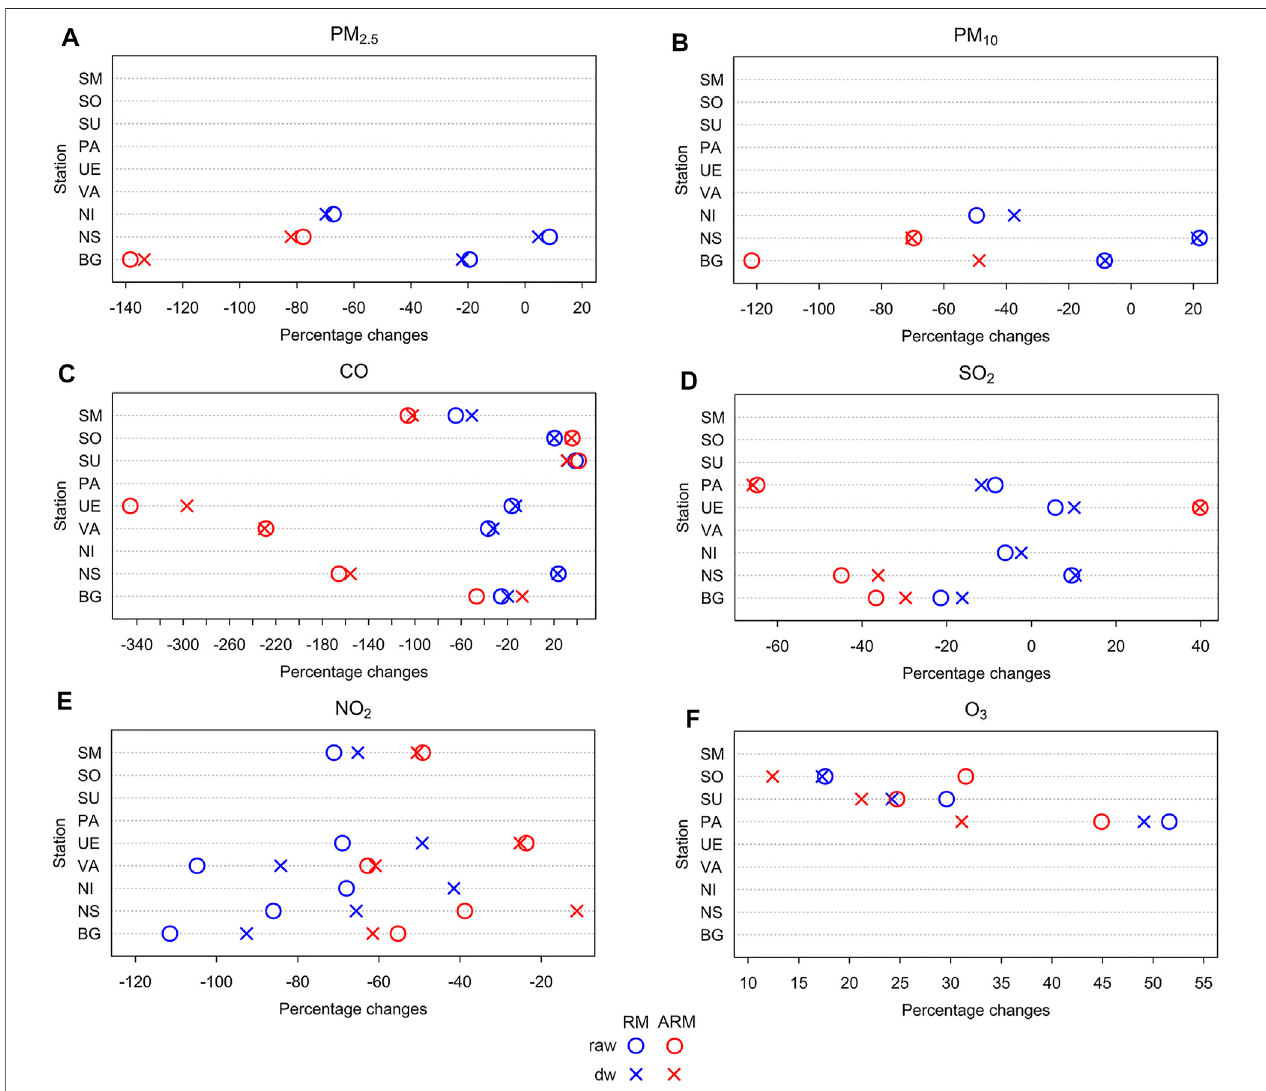
FIGURE 4 | Percentage changes of city-speci fi c pollutant concentrations in restrictive measures (RM) and after the restrictive measures (ARM) periods compared to before restrictive measures (BRM) periods for raw and “ deweathered ” data for (A) PM2.5, (B) PM10, (C) CO, (D) SO 2 , (E) NO 2 , and (F) O 3 .